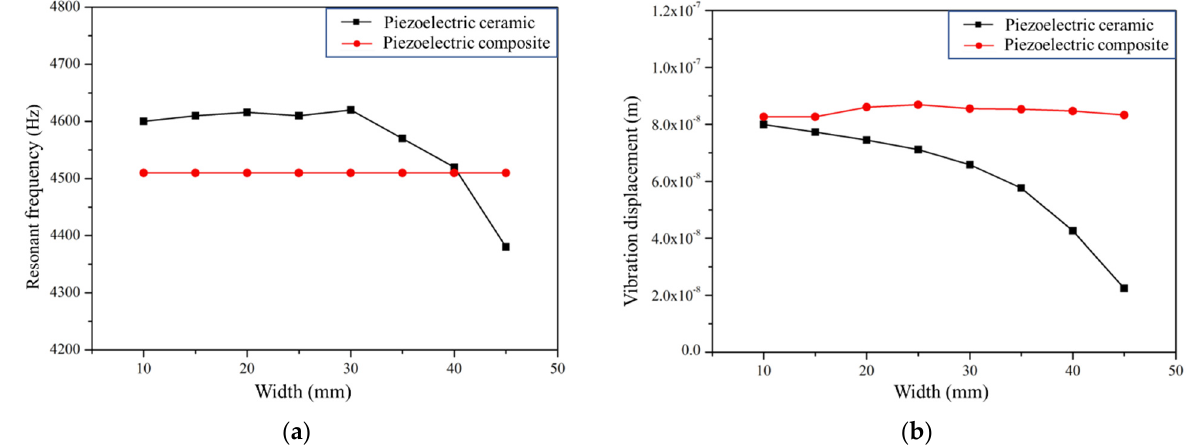
Figure 7. The curve of the resonance frequency and maximum vibration displacement of piezoelectric composite with width. ( a ) Resonant frequency; ( b ) Maximum vibration displacement.